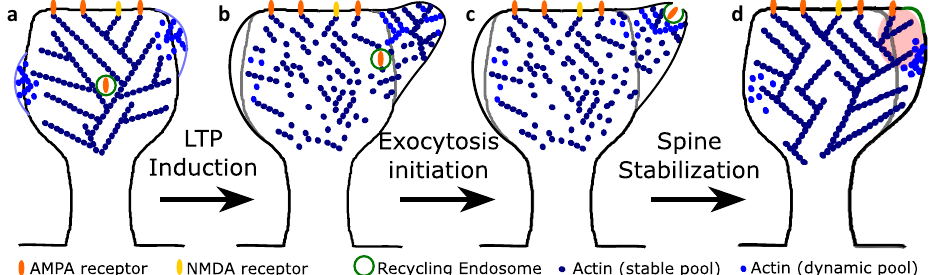
Figure 5. Actin re-organization upon LTP. ( a ) Before LTP induction, actin distributes in a stable and dynamic pool (dark and light blue dots, respectively). Spontaneous shape fluctuations (light blue lines) result from polymerization of the dynamic pool that organizes in distinct foci 9,10,25 . Note that only actin polymerizing close to the membrane can push the membrane forward. ( b ) ≈ 1 min after LTP induction, actin rapidly assembles and disassembles. Actin polymerizes at a single location near to the PSD, elevating the force generated by the membrane tension which triggers exocytosis of the recycling endosome. The initial spine shape is in gray. ( c ) Actin polymerization promotes full fusion of the (cid:31) -profile formed after the docking of the recycling endosome with the spine membrane. ( d ) After completing exocytosis, the spine stabilizes. There is an increase in the AMPARs and spine size. Also, the membrane from the recycling endosome (in green) is merged with the spine membrane. Note that the spine enlargement occurs where the polymerization focus of ( a ) was located (highlighted in red).